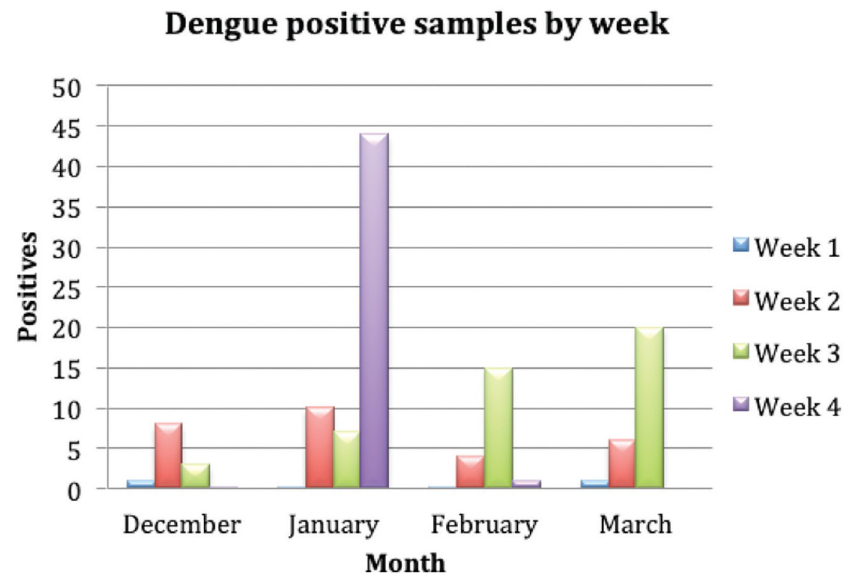
Fig 5. Weekly positive results from December to the 24 th March 2017.